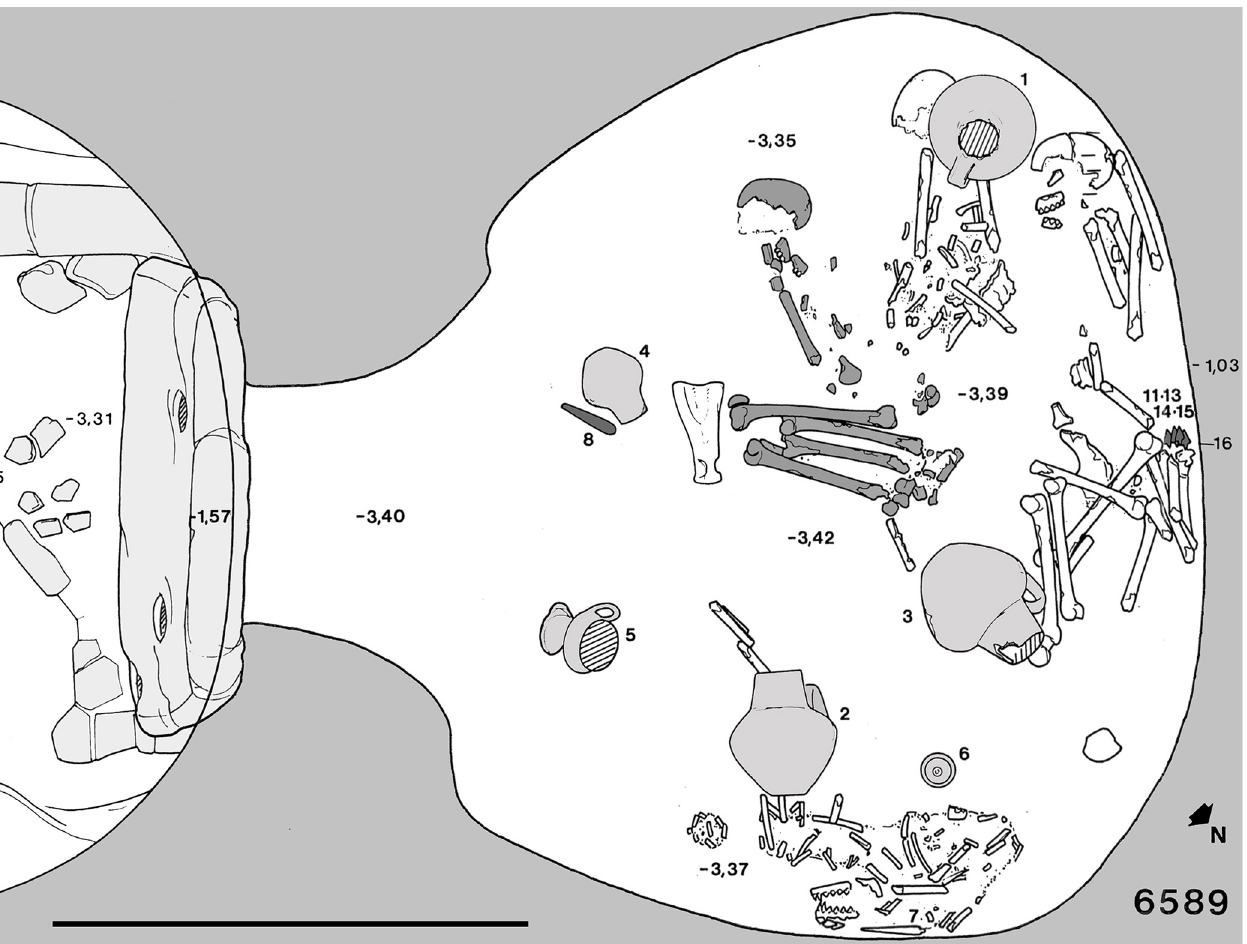
Fig 1. Plan of grave PC 6589. Grave 6589 consists of a single funerary chamber and a pit. The last deposition (specimen 6589.1, dark gray) is positioned at the center of the chamber, while three more skeletons are shifted (secondary burial) to the north-west side. A further group of bones belong to a dog ’ s skeleton. Scale bar measures 1 meter (modified from Bailo Modesti et al. 1998).